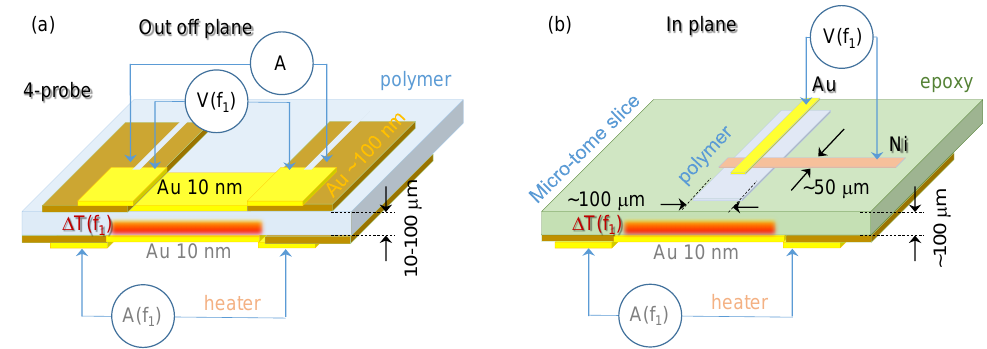
Figure 1. Two modalities of thermal wave measurements using detection by a resistance ( a ) and thermocouple ( b ) directly applied to the sample (polymer); the heater is sputtered directly on the opposite side of the sample. Temperature diffusivity in direction normal to the polymer sheet (out-of-plane) and along the plane (in-plane) can be measured. A micro-tome slice is used to prepare samples for the in plane heat transport measurements. The heat source is modulated at frequency f 1 = 4–36 Hz and detected by lock-in